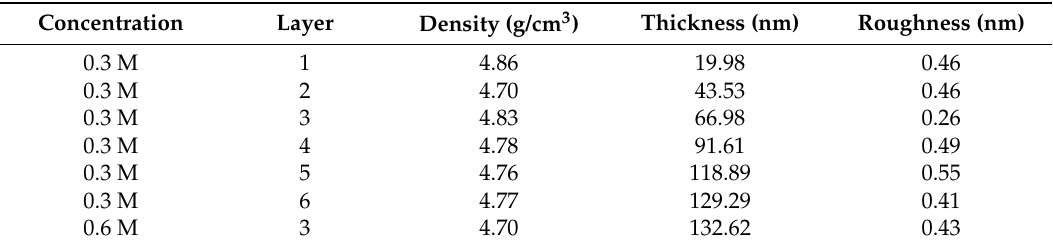
Figure 2. XRD spectra of ZrO 2 films with different post-annealing temperatures. ZrO 2 film of ( a ) 67 nm and ( b ) 130 nm.